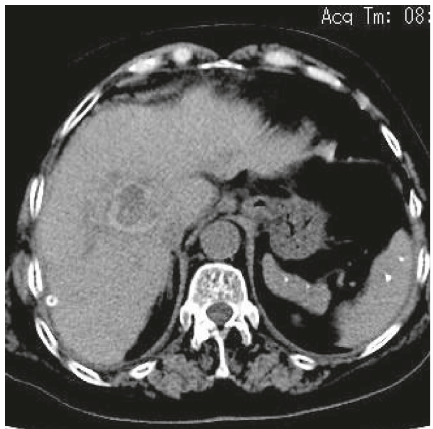
Figure 2: Two weeks after surgery, CTshowed obvious absorption of intrahepatic hemorrhage, which was significantly improved compared with previous